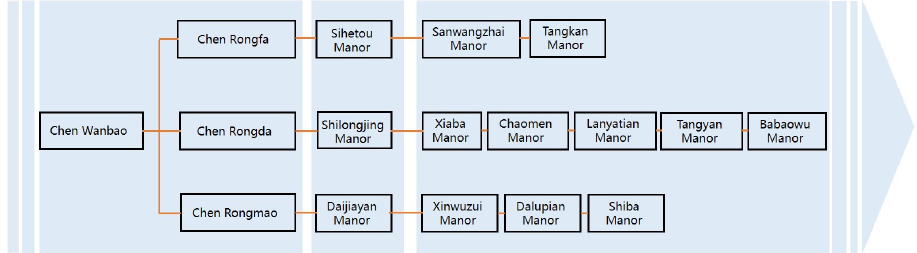
Figure 5. Context of the expansion of the Chen manors (source: Drawn by the